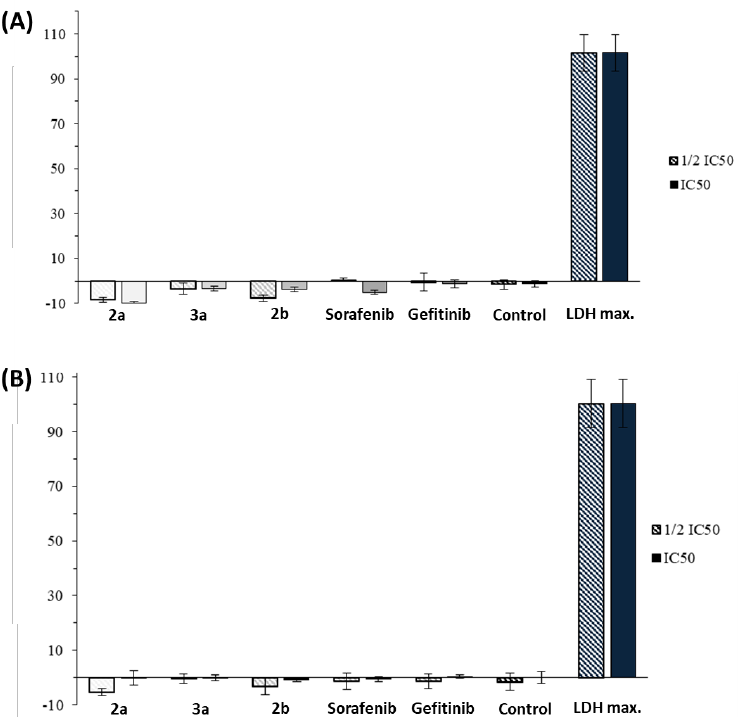
Figure 6. LDH release by 2a , 2b and 3a in HCT-116 wildtype ( A ); and p53-knockout ( B ) cells. Sorafenib and gefitinib (25 µ M and 50 µ M for HCT-116 wildtype cells) were used as positive controls. y-axis: LDH release in %. n = 3 ± SD.